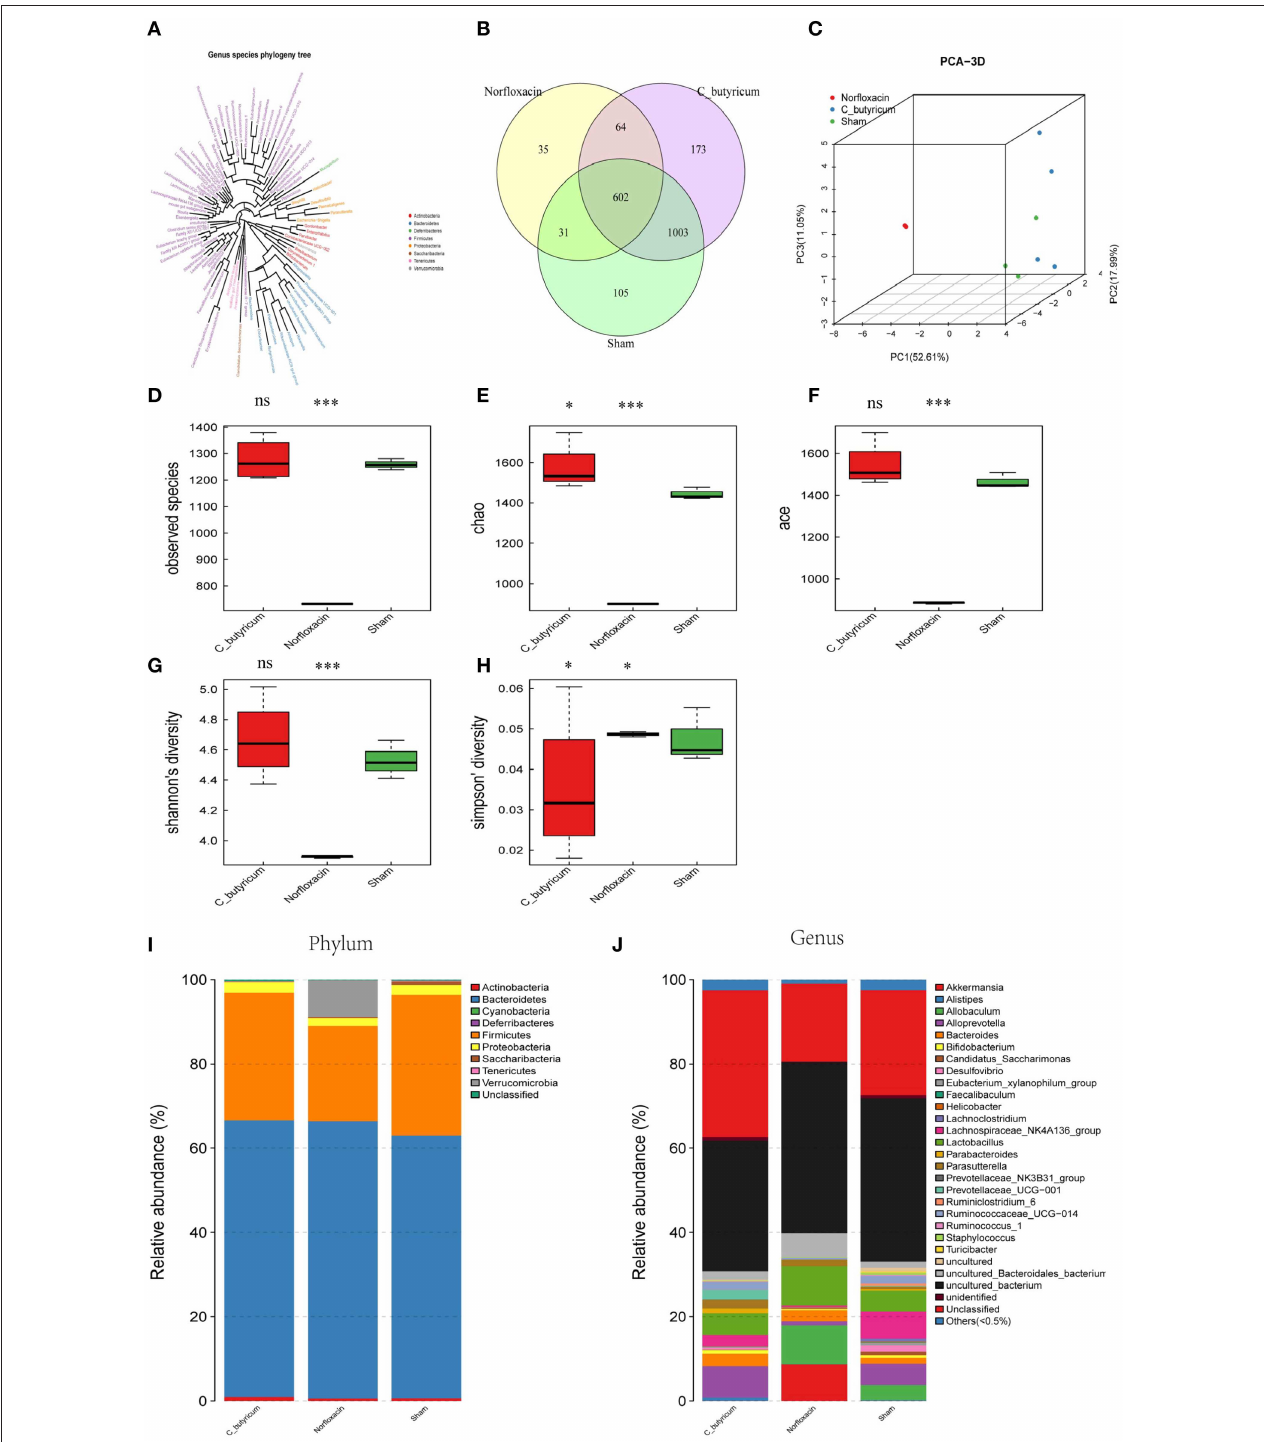
FIGURE 2 | Responses of the diversity, richness, and structure of the gut microbiota to sham, C. butyricum, and norfloxacin treatment in EAE mice. (A) Genus species phylogeny tree of all three groups. (B) Venn diagram of each group and the number of differences between species are shown. (C) Unweighted Unifrac principal coordinates analysis plots 3D of each sample and the distance of each group are shown. Each sample was collected from three mice ( n = 3). (D–H) shows the Observed species index, Shannon index, Chao index, Simpson index, and ACE index of each group. (I–J) Relative abundances of the gut microbiota at phylum level and genus level. Statistically significant data are indicated by asterisks (* P < 0.05 and *** P < 0.001). ns, not significant.